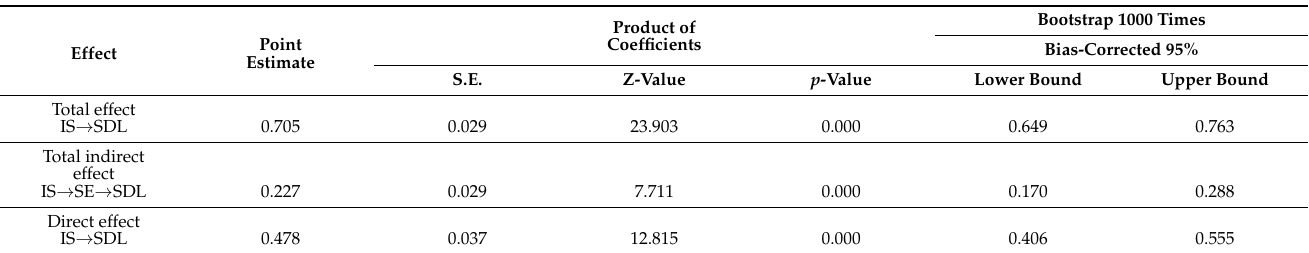
Table 8. The analysis of indirect